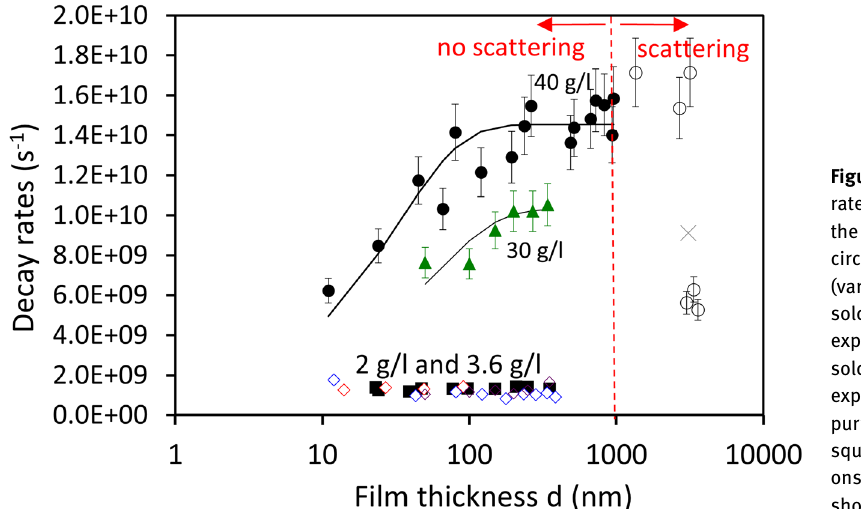
Figure4: (a)Experimentalemissionkineticsatlow ν =2g/landhigh ν =40g/ldyeconcentrationsandtheir fi tswithexponentialfunctions.(b) EmissionkineticsofHITC:PMMA fi lmsdepositedonglassatthe fi lmthicknessesrangingfrom d =15nmto d =364nmatlowdyeconcentration ν = 2 g / l (adopted from Ref. [28]) and from d = 11 nm to d = 957 nm at high dye concentration ν = 40 g / l .